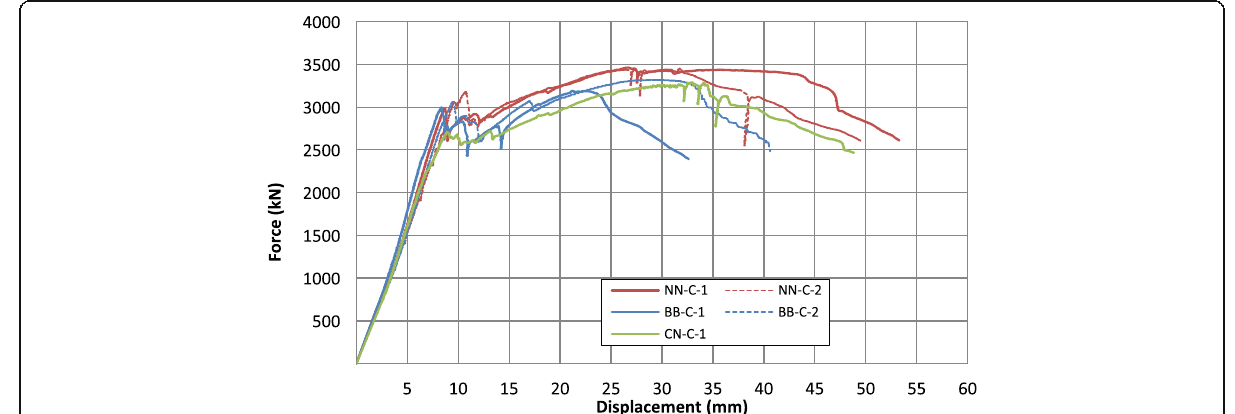
Fig. 9 Compression force versus axial displacement of control specimens